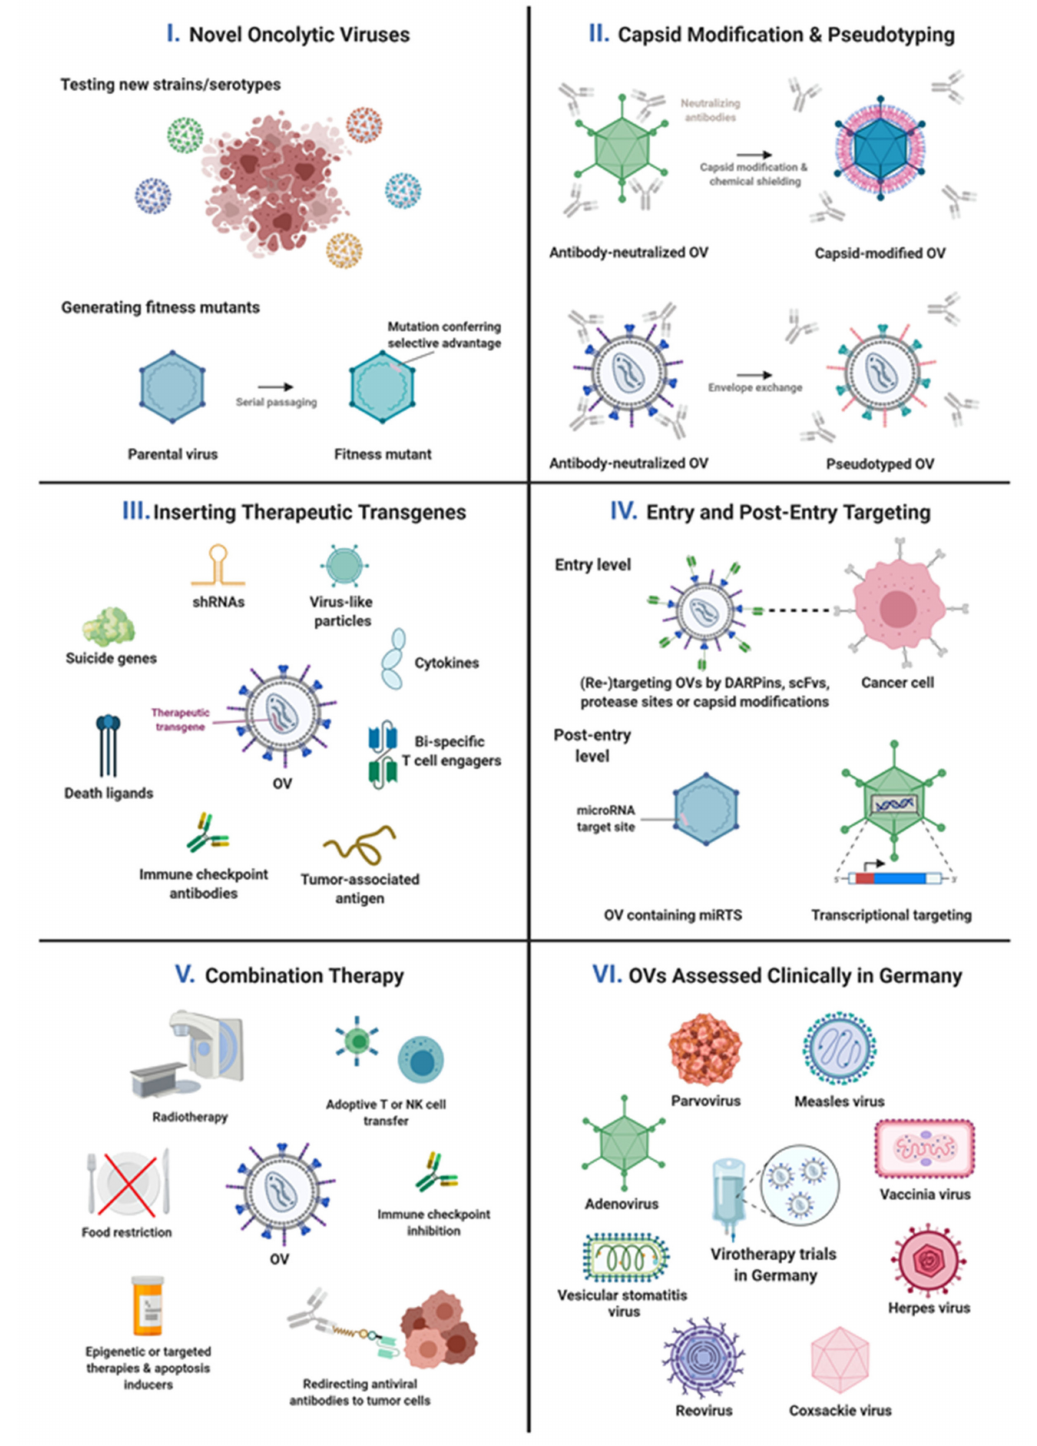
Figure 1. Overview of recent pre-clinical and clinical virotherapy research activities in Germany. Created with